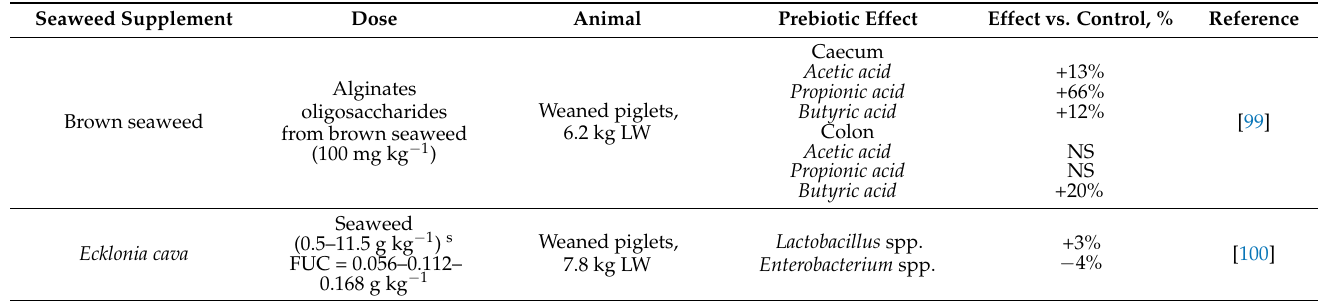
LAM: laminarin; FUC: fucoidan; SCFA: short-chain fatty acids. a Sum of non-starch polysaccharidemonomers and lignin = 503 g kg − 1 . c Laminaria extract with a content of 112 g kg − 1 Laminarin and 89 g kg − 1 Fucoidan. y Laminaria extract with a content of 990 g kg − 1 Laminarin. z Laminaria extract with a content of 720 g kg − 1 Fucoidan. k Laminaria extract with a content of 455 g kg − 1 Laminarin and 360 g kg − 1 Fucoidan. s Ecklonia cava with a content of 112 g kg − 1 Fucoidan. r 653.2 g kg − 1 Laminarin, 190 g kg − 1 Fucoidan. m Alginic acid oligosaccharide (ALGO) is the lyase–lysate of alginic acid, which is a naturally occurring anionic polysaccharide isolated from the cell walls of seaweed polysaccharide isolated from the cell walls of seaweed. n 441 g kg − 1 fucoidan, 25.9 g kg − 1 laminarin, 135 g kg − 1